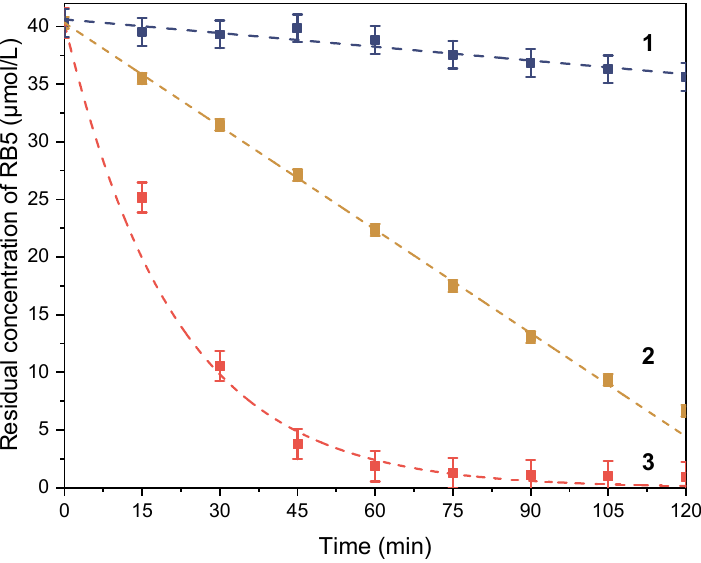
Figure 1. Degradation kinetics of RB5 using ( 1 ) Fe 2 O 3 (hematite), ( 2 ) F2 and ( 3 ) F1 as catalysts.